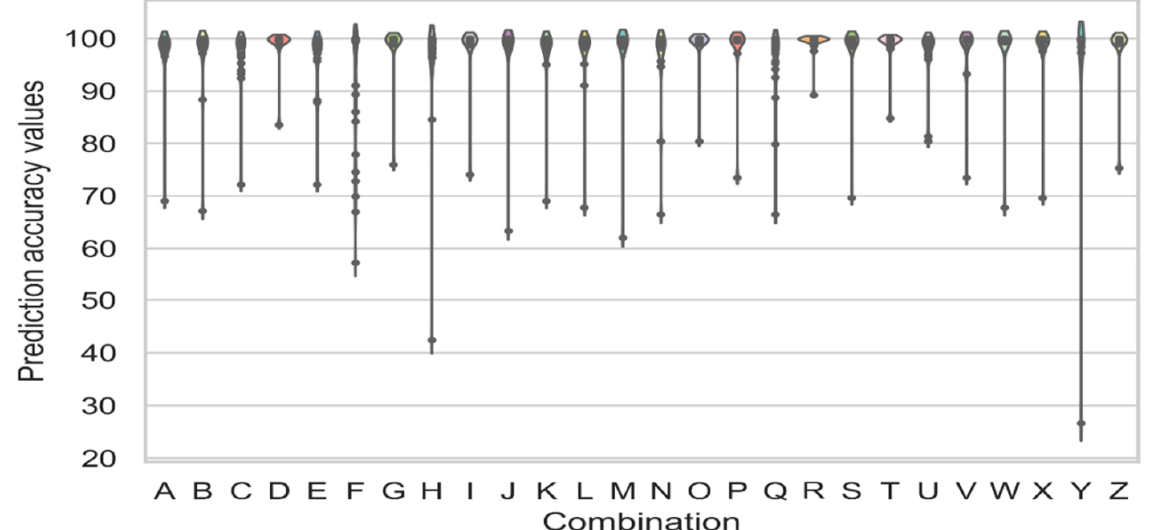
Figure 7. Prediction accuracy values for the CNN model were applied to the 26 combination cases of the five best fingerprints with the help of violin-plot charts.